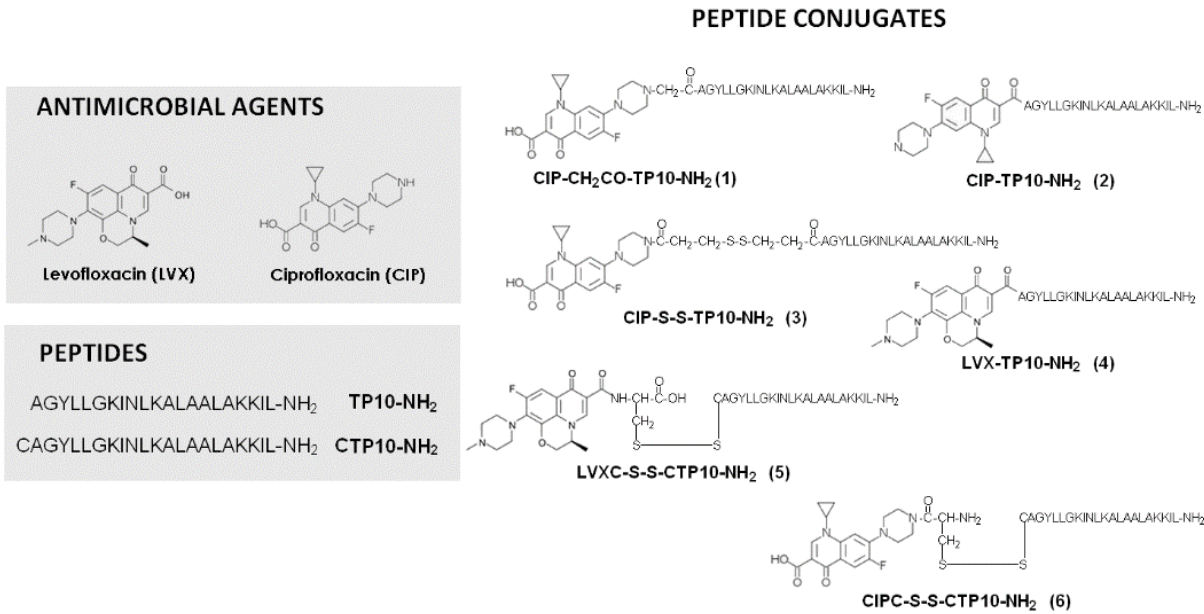
Figure 1. Chemical structures of the CIP and LVX conjugates with transportan 10 and their constituents [26].